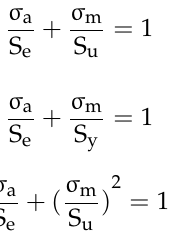
Figure 23. Comparison of mean stress equations.